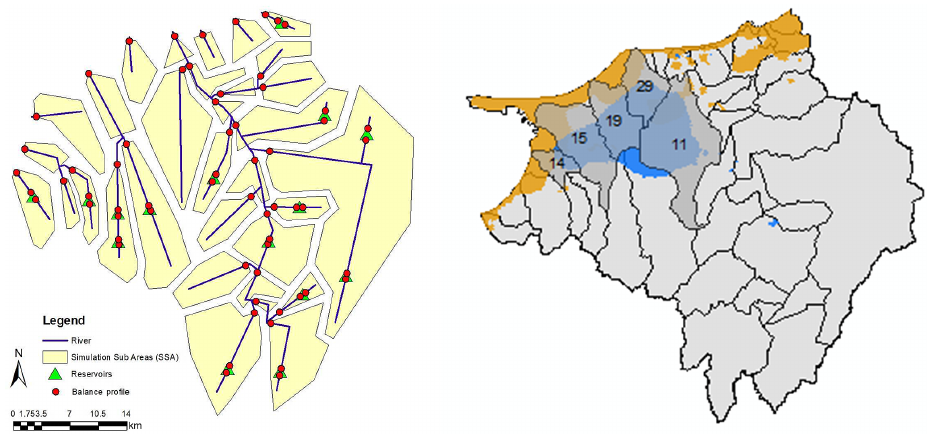
Figure 5. Left: Subdivision of the basin into water balance units, connected by river links, Right: Areas where the water extraction has to be reduced urgently (dark grey); the areas in orange show strong saltwater intrusion (mass concentration >400mgL − 1 , after 40 years of simulation without intervention); the areas in blue indicate a groundwater depression cone (hydraulic heads ≤ 3m, after 40 years of simulation without intervention).